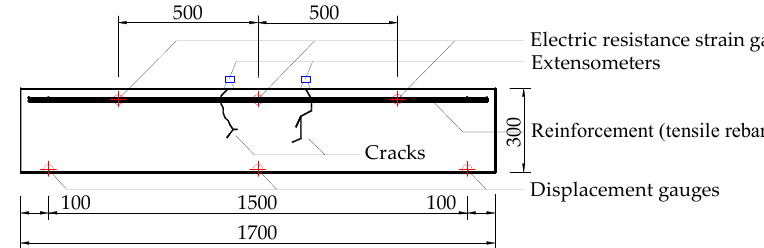
Figure 3. Layout of strain and displacement gauges (mm).